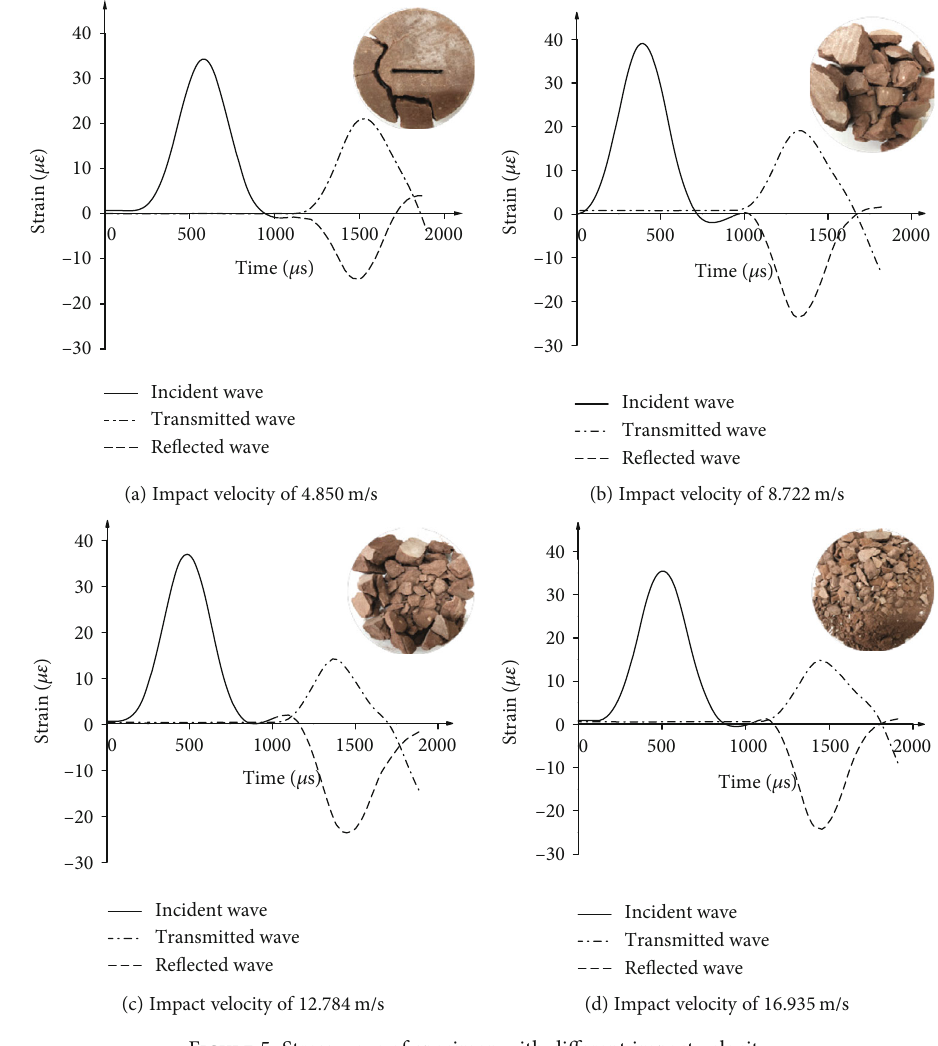
Figure 5: Stress wave of specimen with di ff erent impact velocity.